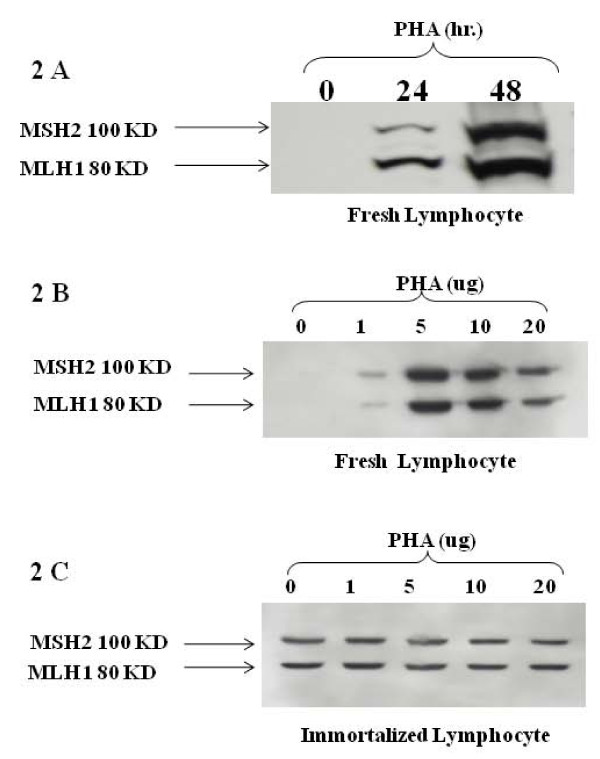
Expression of MLH1 and MSH2 proteins in fresh blood and in immortalized lymphocytes following PHA stimulation. (A) Time-dependent stimulation of MLH1 and MSH2 proteins in fresh blood lymphocytes following PHA treatment. The expression of MLH1 and MSH2 proteins increased in a time dependent manner. These proteins were often not detectable without PHA stimulation. (B) Dose response of fresh lymphocytes to PHA. Lymphocytes were stimulated with the indicated concentrations of PHA for 48 hrs. The expression of MLH1 and MSH2 proteins in fresh blood lymphocytes increased in a dose-dependent manner. (C) Dose response of immortalized lymphocytes to PHA. There was no effect of PHA on immortalized lymphocytes. MLH1 and MSH2 proteins were detectable even without PHA stimulation.